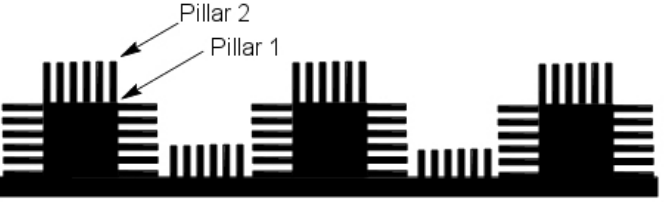
Figure 3. Biomimetic design inspired from the double nanostructured pillars on the surface of a lotus